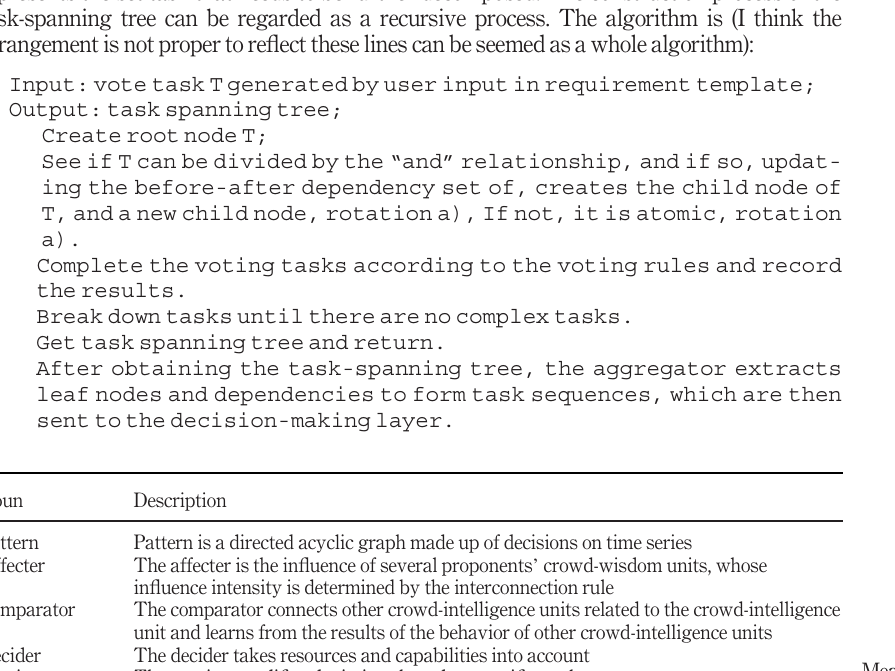
Table II. Meaning of each